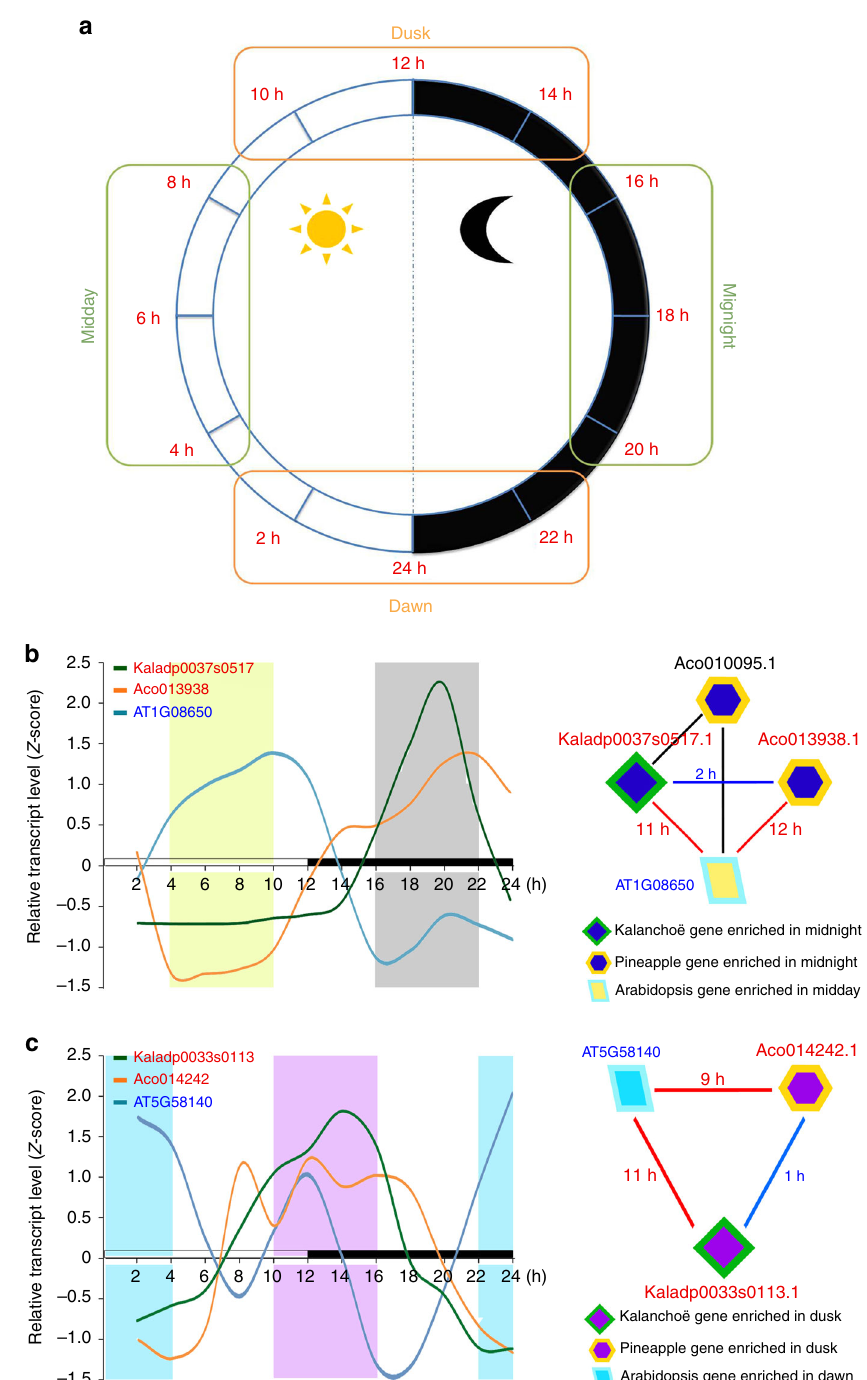
Fig. 4 Examples of convergent change in diel transcript expression pattern in CAM species. a The four time-windows for comparative analysis of temporal changes in transcript expression, which were represented by 12 time points: 2, 4, … , 24 h after the beginning of the light period. b and c Comparison of diel transcript expression pattern of phosphoenolpyruvate carboxylase kinase 1 ( PPCK1 ) and phototropin 2 ( PHOT2 ), respectively, between CAM species ( Kalanchoë fedtschenkoi and pineapple) and C 3 species ( Arabidopsis ). Left panels show the diel transcript expression pro fi les. Right panels show enrichment triangle networks, in which a K. fedtschenkoi gene and a pineapple ortholog had signi fi cantly enriched expression in the same time-window, whereas an Arabidopsis ortholog had signi fi cantly enriched expression in the opposite time-window. The numbers are the time shifts in diel transcript expression pattern between genes connected by each edge. White and black bars indicate daytime (12-h) and nighttime (12-h), respectively. X-axis represents the time after the beginning of the light